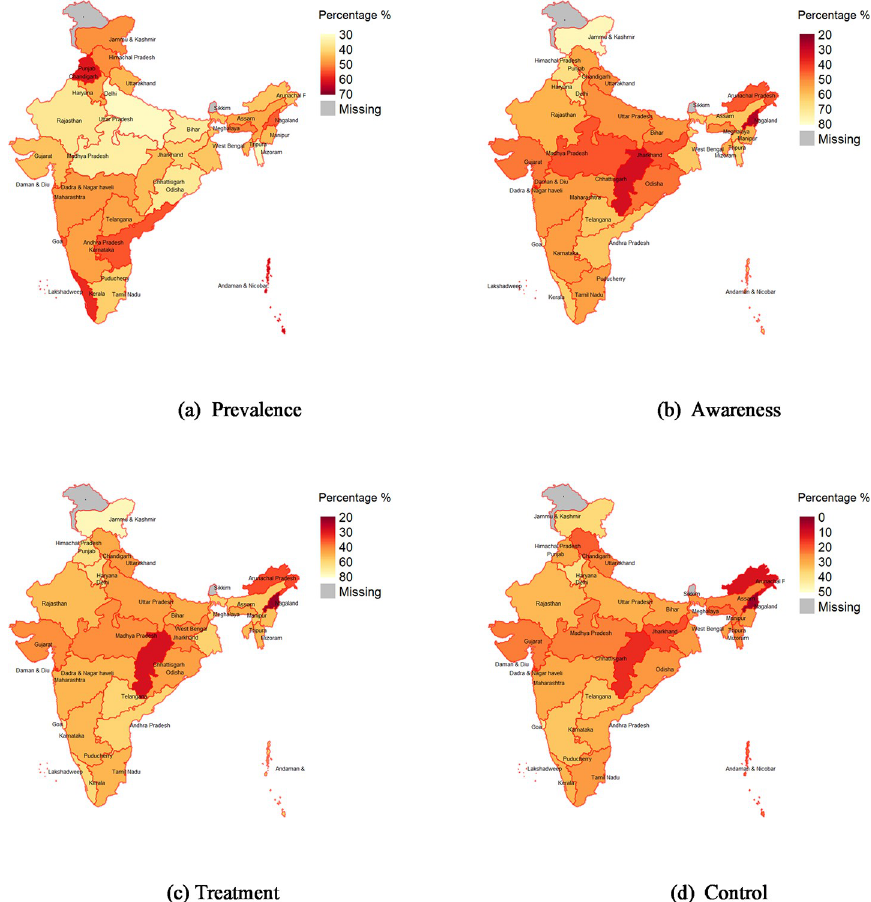
Fig 2. Adjusted hypertension prevalence and percent aware, treated, and controlled among those with hypertension by state, adults aged 45 years and over and their spouses. The base map can be found at https:// globalsolaratlas.info/download/india. Notes: Adjusted for age and sex. State-specific estimates of age sex adjusted hypertension prevalence and rates of ATC in table form are presented in S8 Table, and unadjusted estimates are presented in S9 Table. ATC, awareness, treatment, and